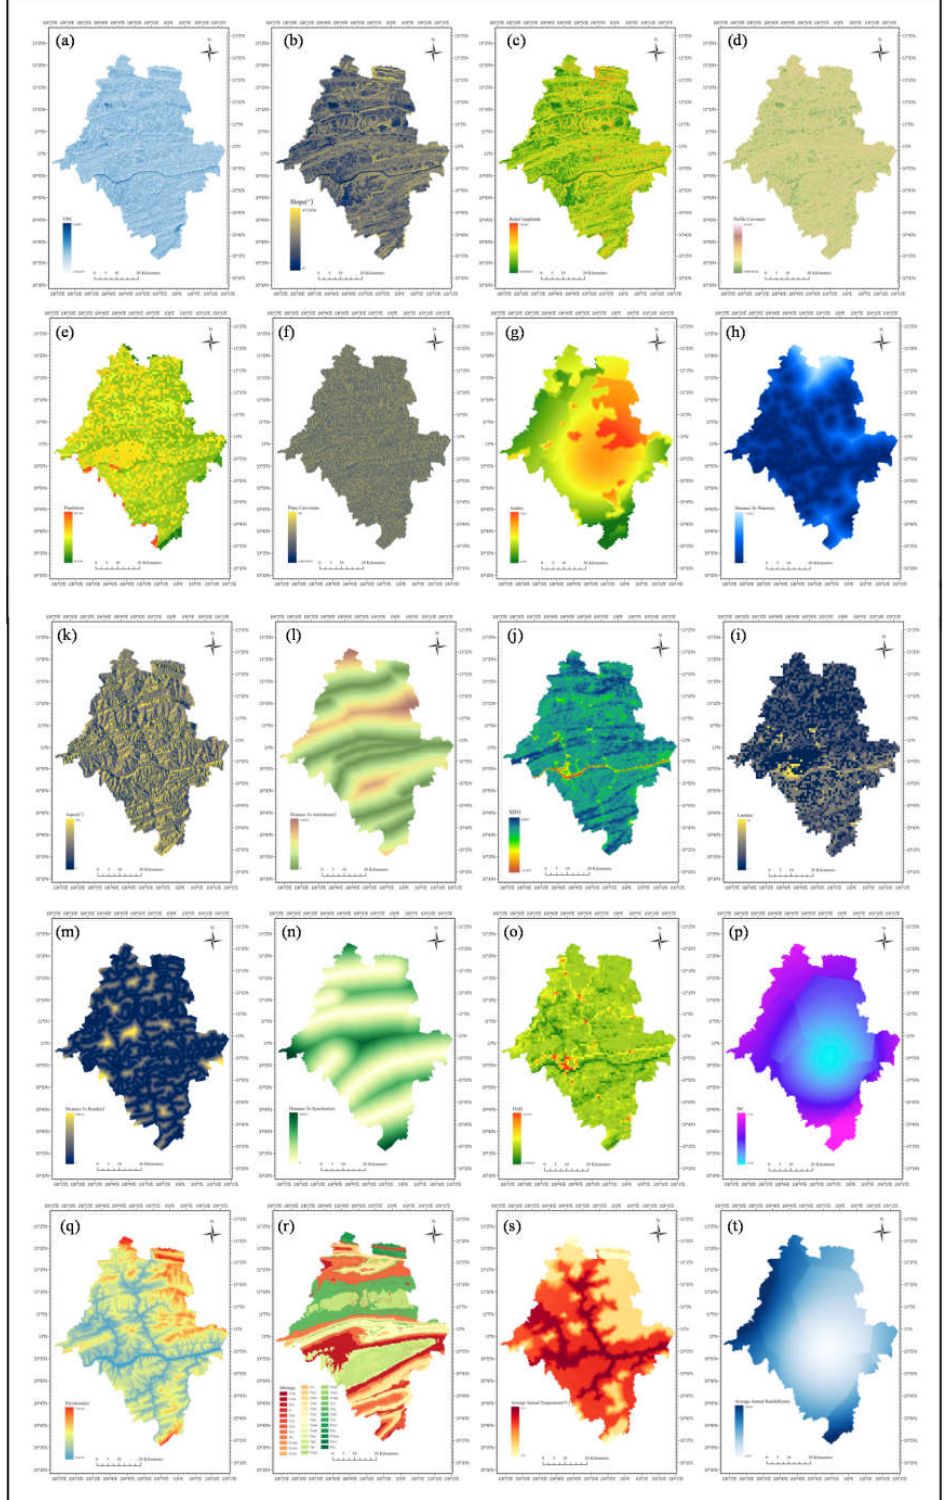
Figure 7. Conditioning factors of landslides susceptibility: ( a ) TWI; ( b ) Slope; ( c ) Relief amplitude; ( d ) Profile curvature; ( e ) Population; ( f ) Plane curvature; ( g ) Aridity; ( h ) Distance from rivers; ( i ) Land use; ( j ) NDVI; ( k ) Aspect; ( l ) Distance from anticline axis; ( m ) Distance from road; ( n ) Distance from syncline axis; ( o ) HAILS; ( p ) IM; ( q ) Elevation; ( r ) Lithology; ( s ) Average annual temperature; ( t ) Average annual